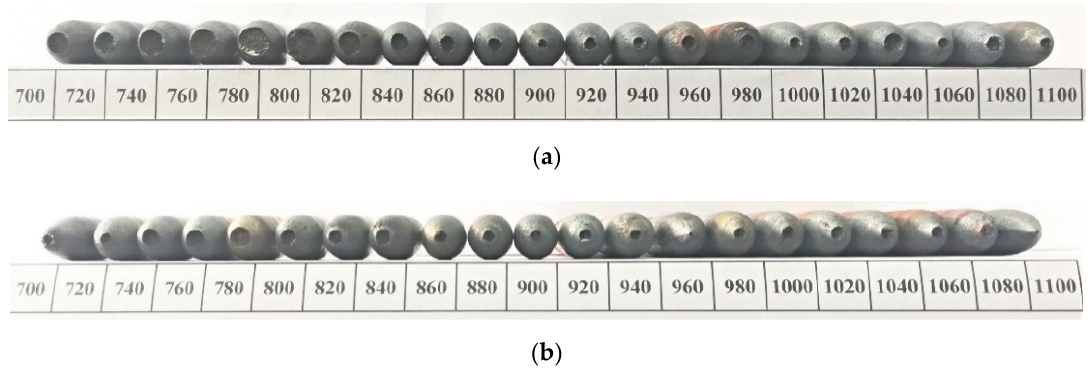
Figure 7. Macro fracture appearance of tensile specimens. ( a ) Before magnesium treatment. ( b ) After magnesium treatment.